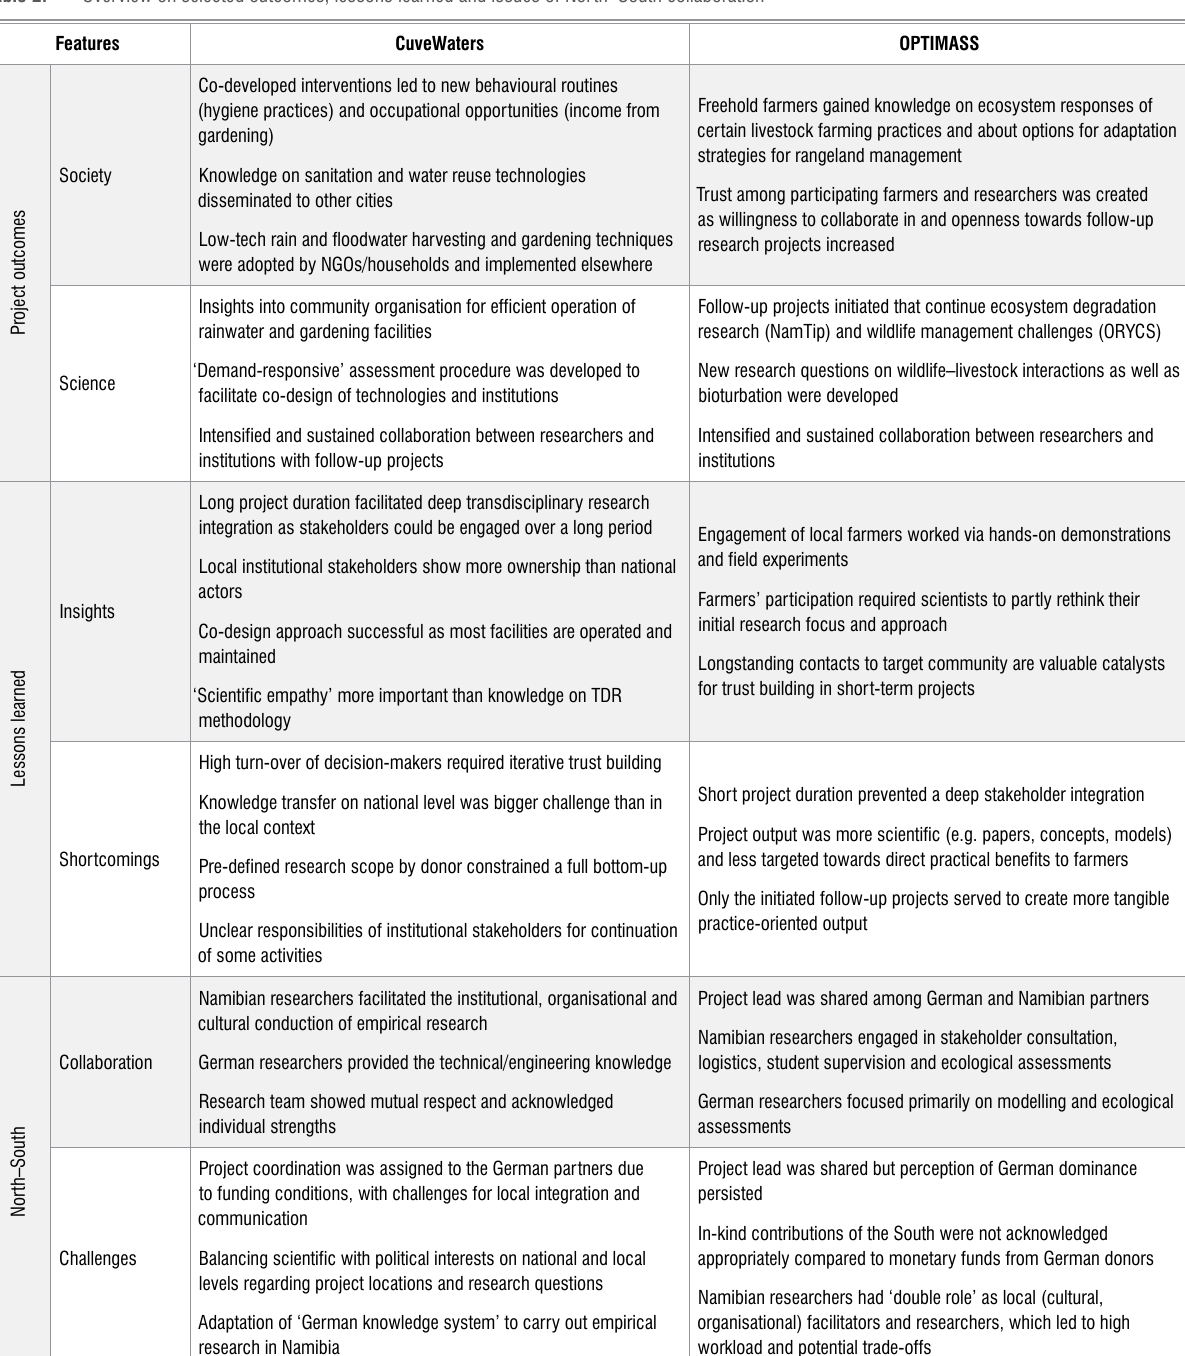
Table 2: Overview on selected outcomes, lessons learned and issues of North–South collaboration